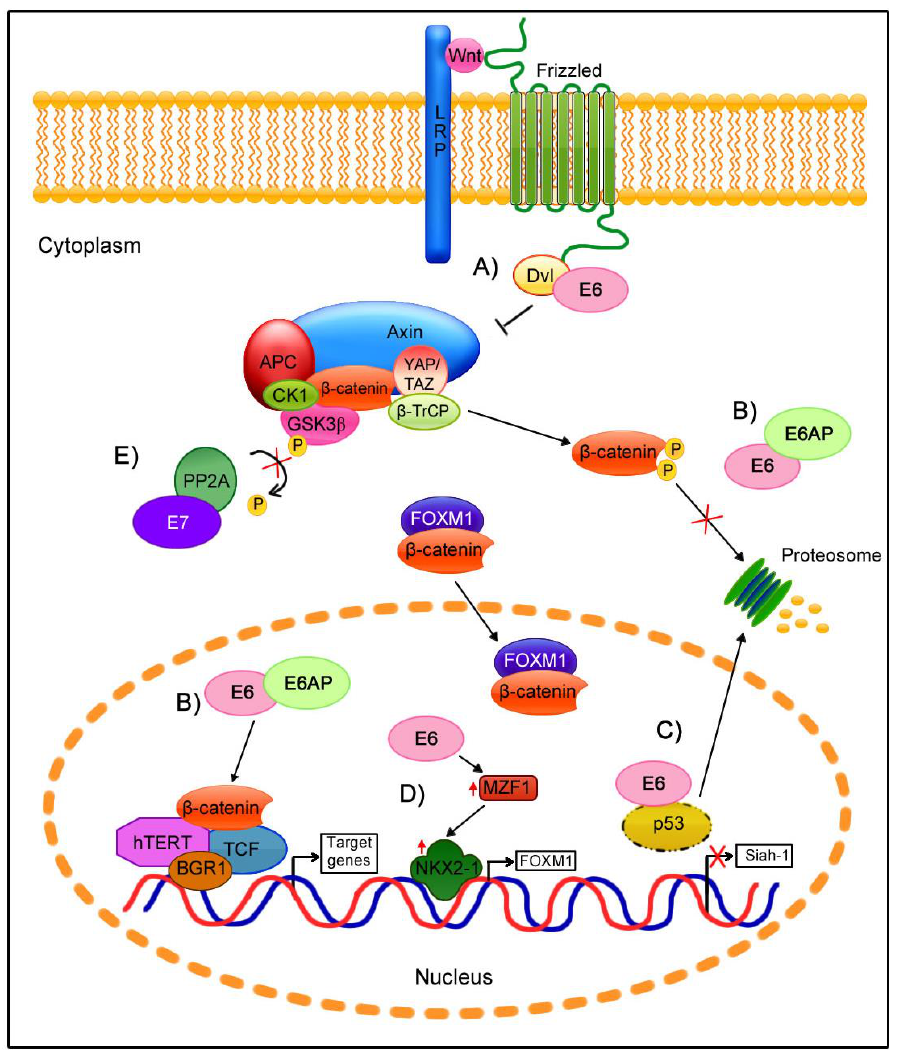
Figure 2. Participation of HPV oncogenes at different levels of Wnt/β-catenin cell signaling regulation. ( A ) The binding of E6-Dvl can disrupt the β-catenin degradation complex, releasing β-catenin which then accumulates in the cytoplasm; ( B ) The E6/E6AP complex stabilizes β-catenin, avoiding its proteasomal degradation and promoting its nuclear translocation, which results in an increase in TCF transcriptional activity; ( C ) E6-induced p53 degradation inhibits Siah-1 expression, which reduces β-catenin degradation; ( D ) E6 induces FOXM1 expression via the MZF1/NKX2-1 axis, which promotes FOXM1/β-catenin nuclear translocation and TCF transcriptional activation; ( E ) E7 binds to PP2A in the structural and catalytic domain, which may avoid the GSK3β activation and consequently β-catenin is stabilized.